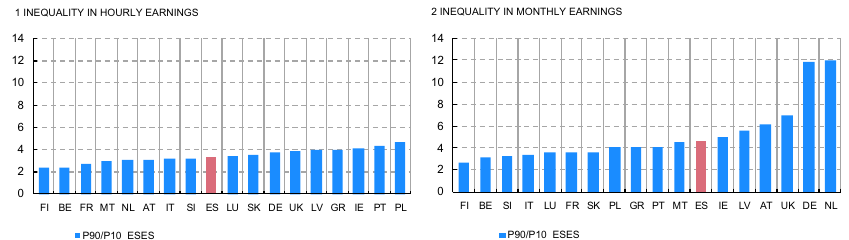
Fig. 1 International comparison of inequality indicators. Wage earnings (2014). Source : Eurostat (European Structure of Earnings Survey - SES)